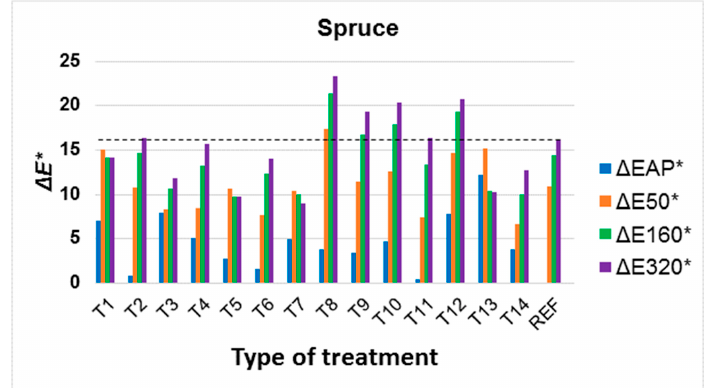
Figure 7. Colour changes in spruce wood after application of surface treatment ( Δ EAP*) and after 50, 160 and 320 h ( Δ E50*, Δ E160*, Δ E320*) of accelerated ageing. (All evaluated total colour changes Δ E* in graph were compared to untreated wood surface.)